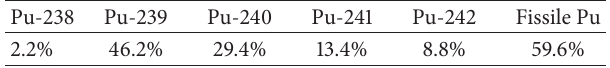
Table 1: Plutonium isotopic